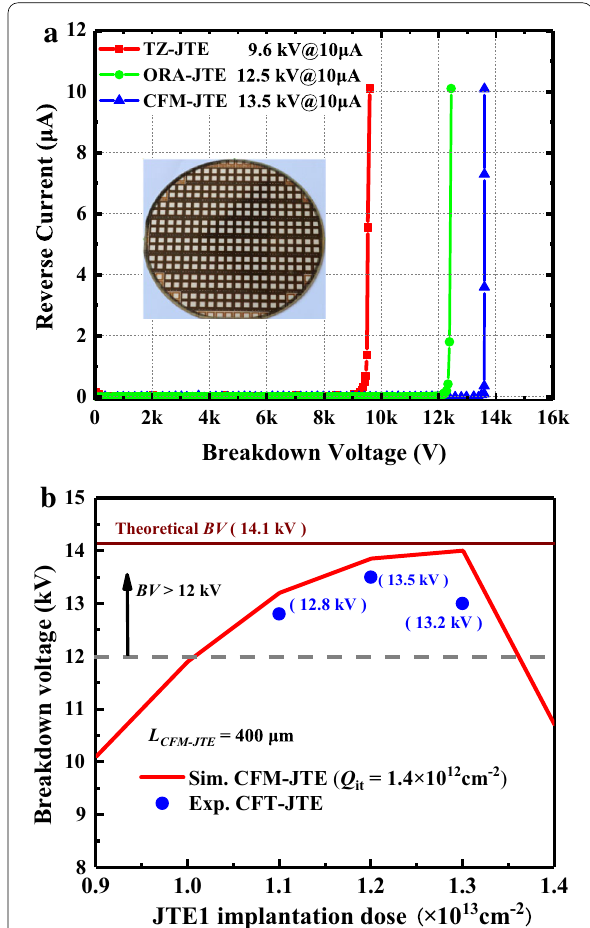
Fig. 12 Breakdown characteristics of the fabricated 4H‑SiC PiN rectifier. a Measured BV of the CFM‑JTE, ORA‑JTE and TZ‑JTE. b Measured BV of the CFM‑JTE with different implantation dose. Solid marks are the experimental values